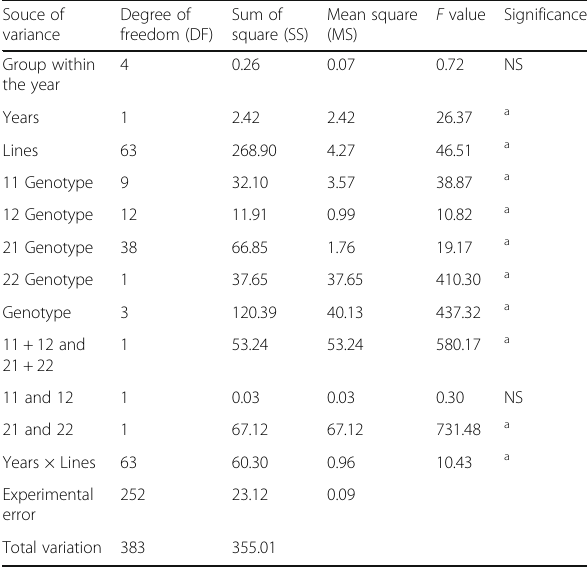
Table 3 Analysis of variance on AC in different genotypes of SSIIa and SSIIIa locus and different years for 64 semi waxy lines Souce of Degree of Sum of Mean square F value Significance variance freedom (DF) square (SS) (MS)